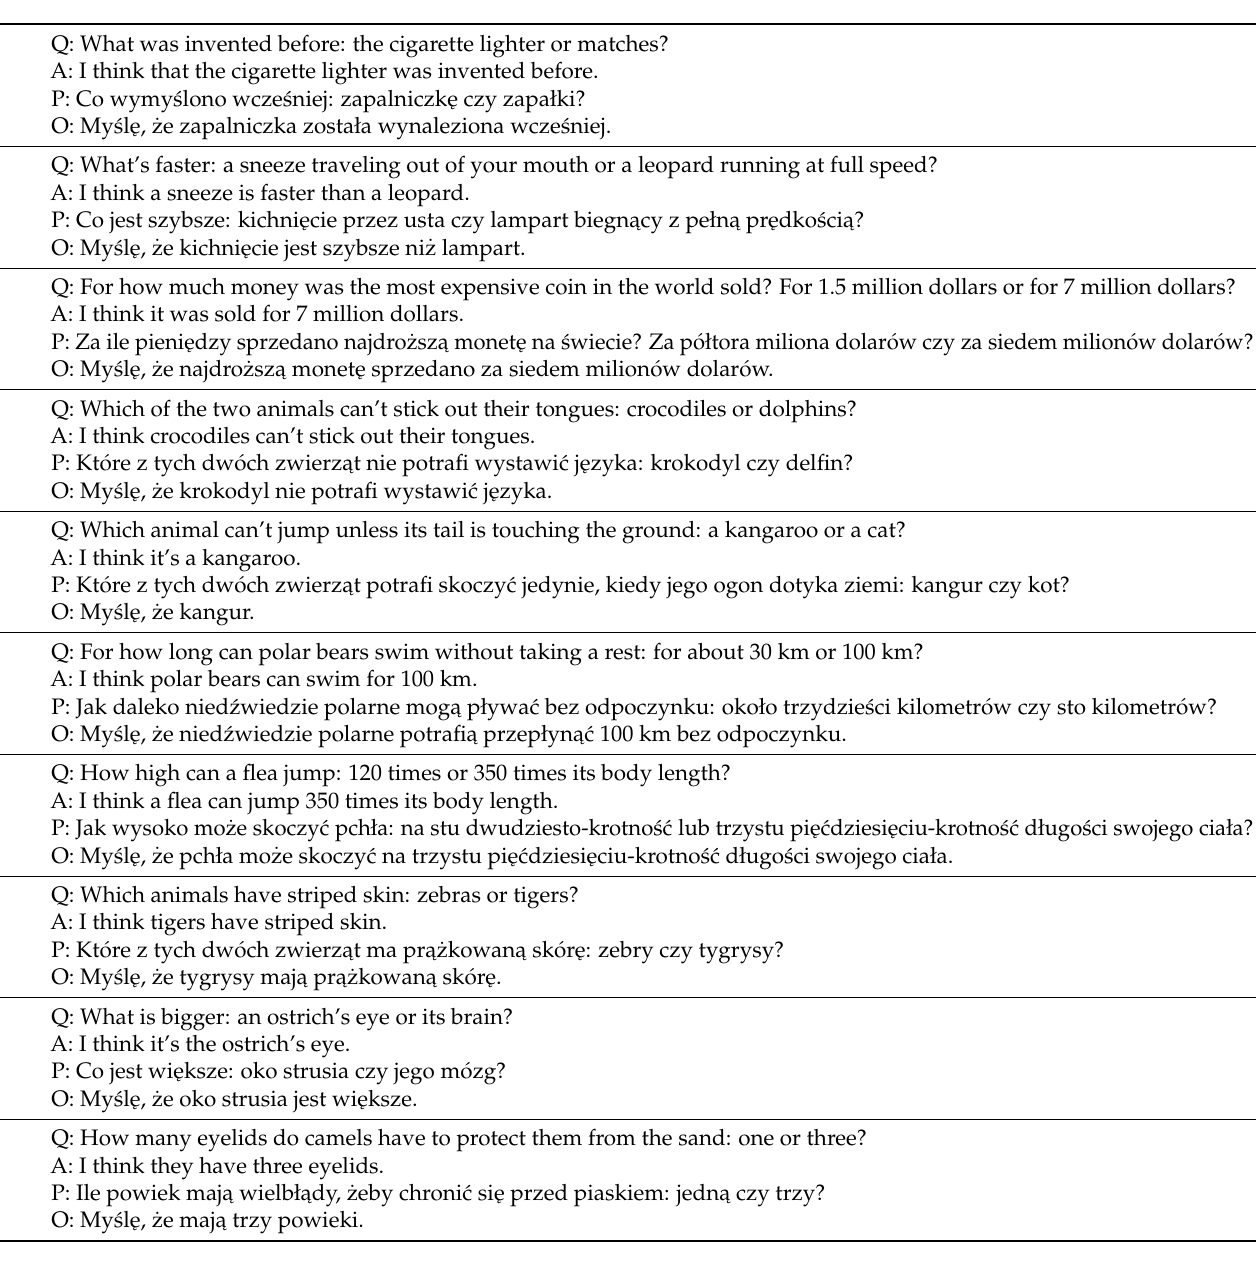
Table A1. Knowledge questions and answers that were used as stimuli for testing perceived knowl- edge and confidence of the respondents. The mini-conversations are presented in English translations and the original Polish versions that were used in the